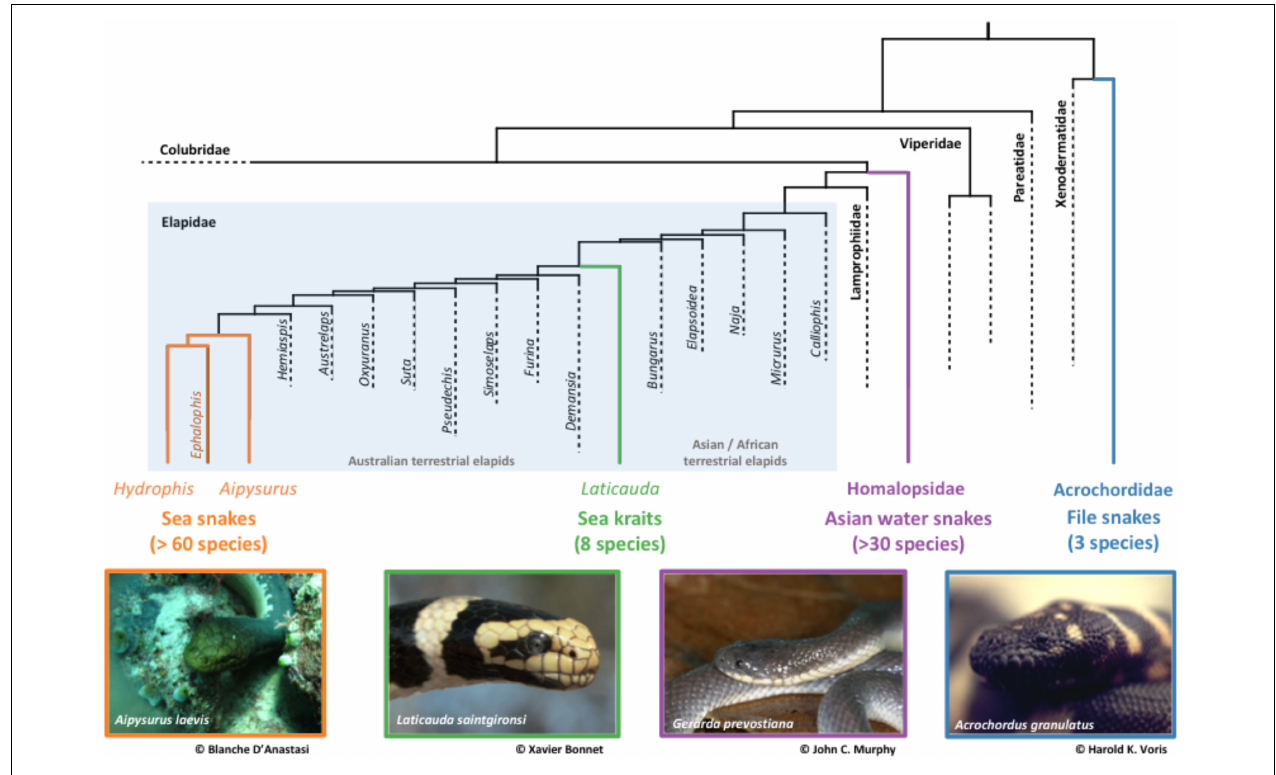
FIGURE 2 | Phylogenetic tree showing relationships between aquatic, semi-aquatic, and terrestrial elapid groups, supporting the hypothesis of two independent transitions into marine environments. Tree modified from Pyron et al. (2013), images provided with permission to use by Blanche D’Anastasi, Xavier Bonnet, John C. Murphy, and Harold K.